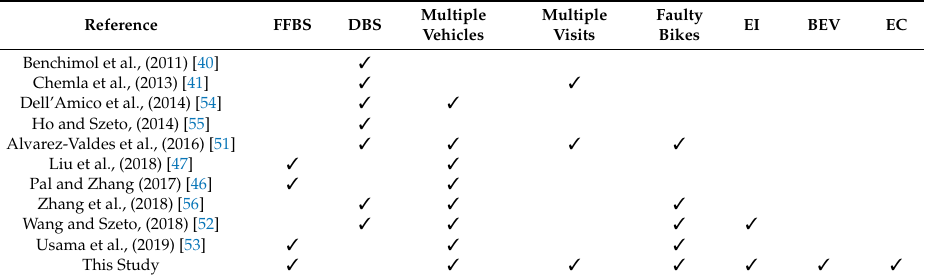
Table 1. Summary of the characteristics of the static rebalancing problems in the literature. Reference FFBS DBS Multiple Vehicles Multiple Visits Faulty